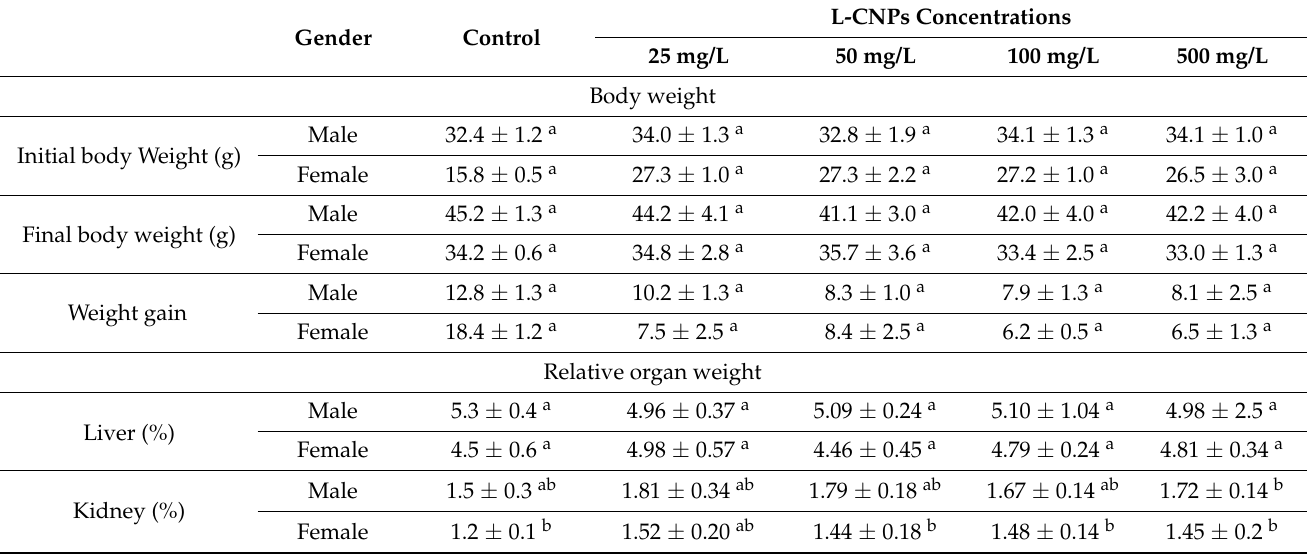
Table 2. Body weight gain and relative organ weight of male and female ICR mice 90-day injection administration of L-CNPs.